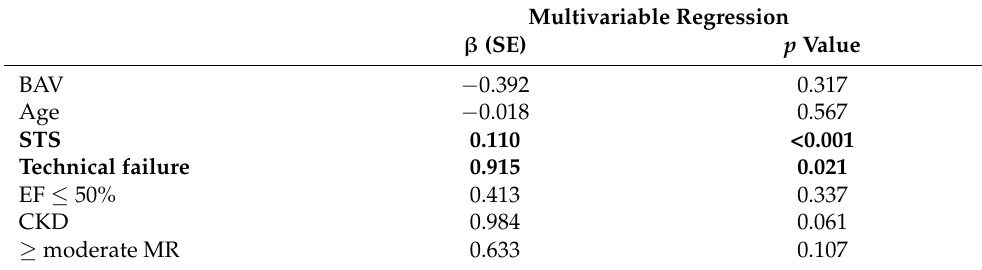
Table 7. Multivariate Cox regression analysis of one-year all-cause mortality, using a Enter Method.